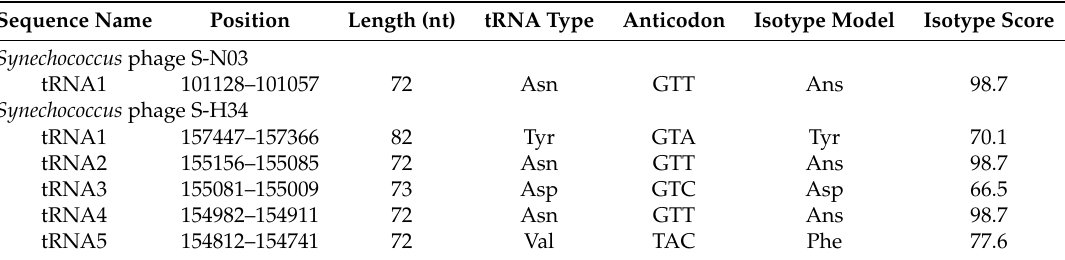
Table 3. tRNA-related information obtained by tRNA